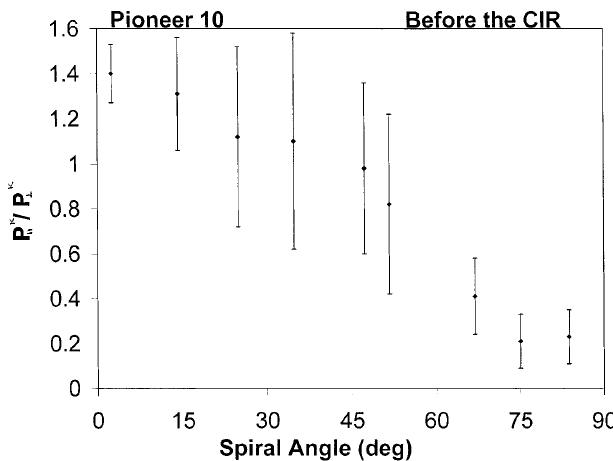
Fig. 7. Ratio of parallel to perpendicular spectra as a function of the spiral angle for the interval of time before the CIR. Directions of spectral components are defined according to